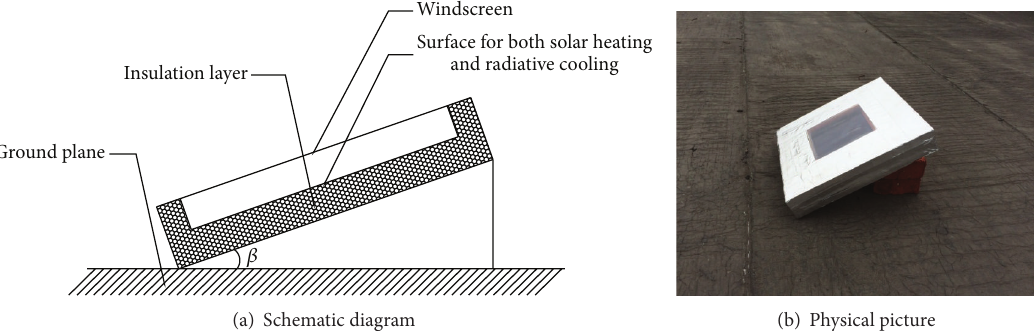
Figure 5: Schematic diagram and physical picture of the solar heating and radiative cooling combined system, where 𝛽 is the inclination